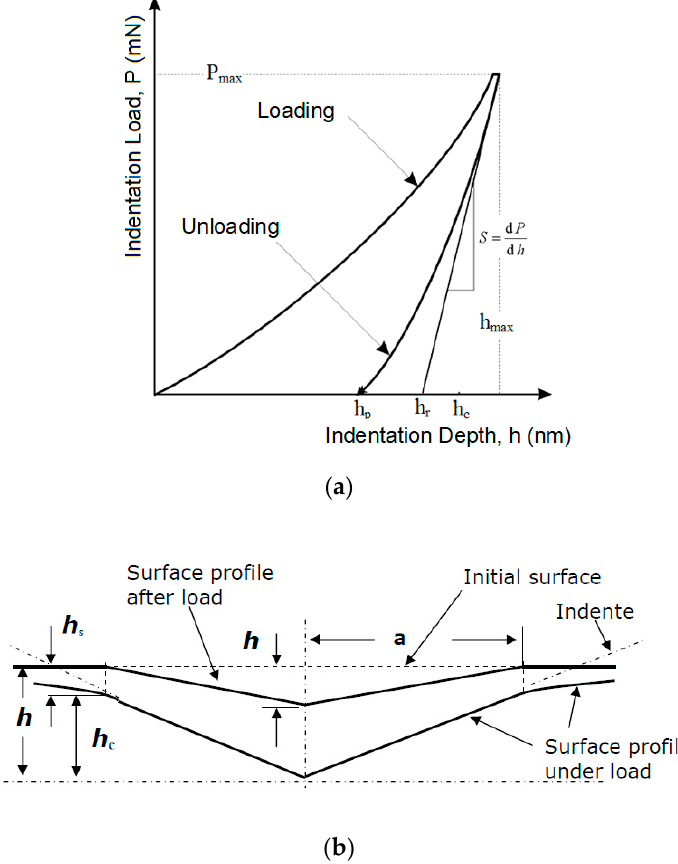
Figure 3. Indentation profile: ( a ) load–displacement curve [30]; ( b ) cross-section of an indentation [30].